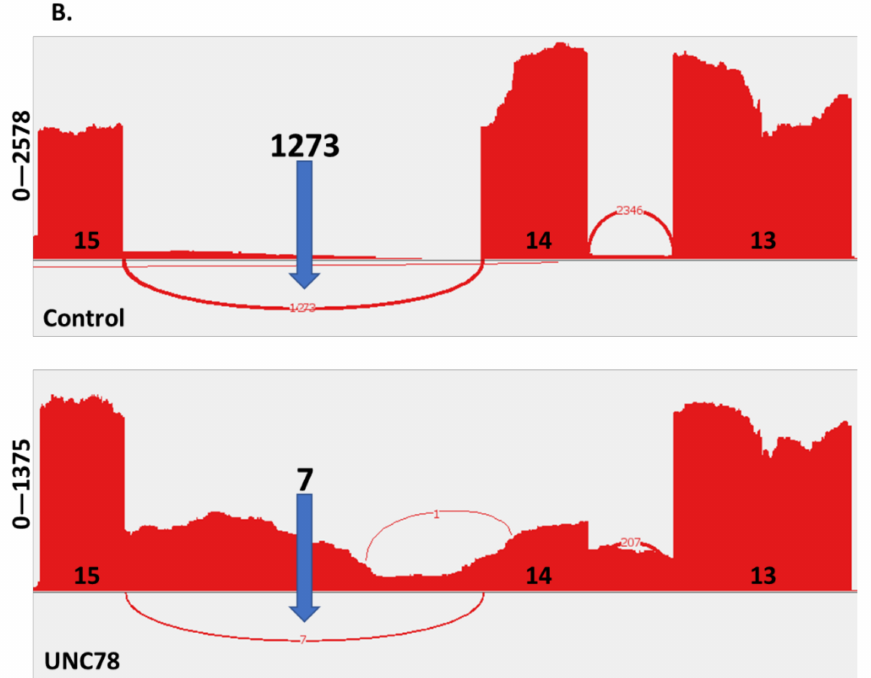
Figure 4. Analysis of ODAD1 transcripts. RNA-seq was performed on RNA isolated from differenti- ated cultures of control HNE cells and UNC78. ( A ) Sashimi plot showing splicing from exon 13 in control (top) and UNC78 (bottom) samples. ( B ) Sashimi plot showing splicing from exon 14. Location of exons (13, 14, 15) is shown along the x-axis; y-axis indicates number of reads. Blue arrows, number of spliced transcripts between the indicated exons. The sample from UNC78 has little evidence of correct splicing. See text for